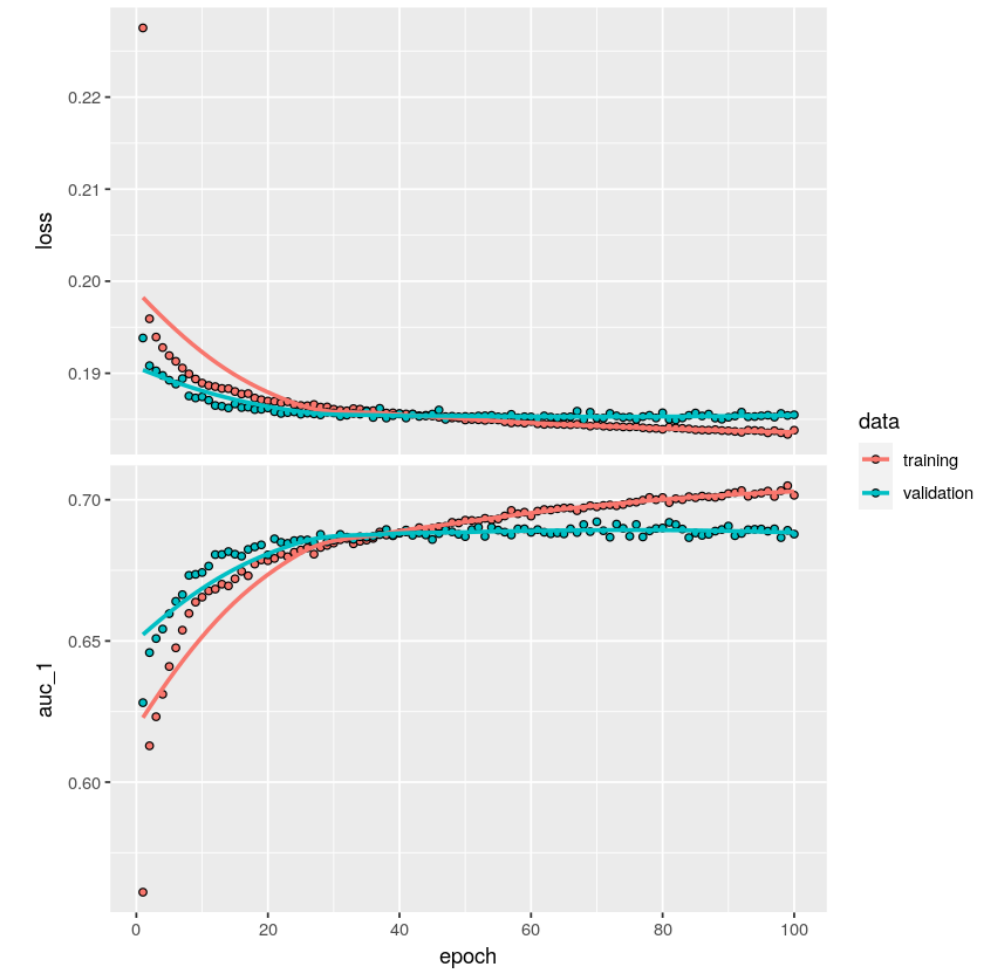
Figure 2. Improvements of deviance loss and AUC metrics over